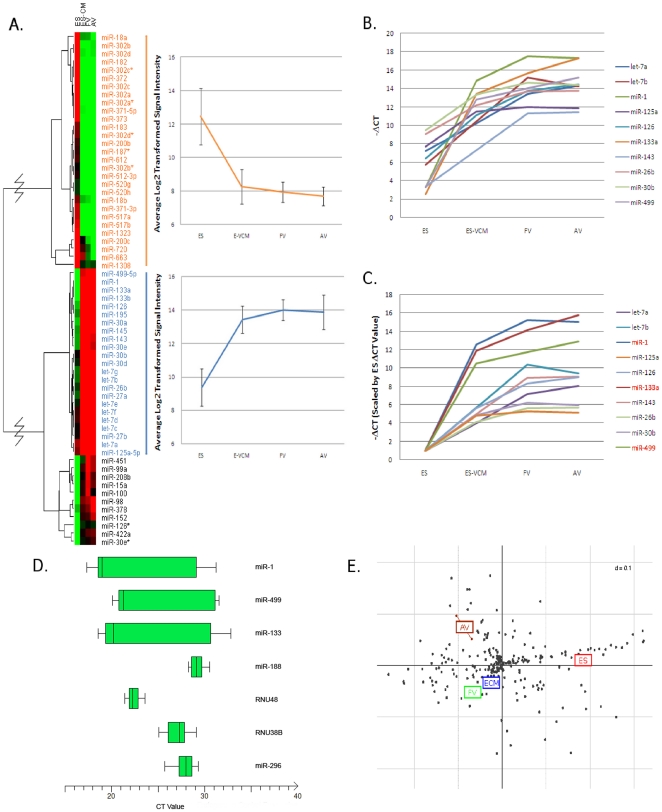
Characterization of miRNAs Present in hESC and Ventricular CMs.(A) A heatmap showing the results of ANOVA differential expression analysis; 63 miRs were differentially expressed between undifferentiated human ESC and hESC-derived VCMs (p<0.05). Red to green indicates high to low expression. Right panels: Average signal intensities of the 29 miRs differentially expressed in hESC (top), and the 23 miRs that displayed a “plateau” pattern across E-, F- and A-VCMs (bottom). (B) “Plateau” miRs validated with quantitative RT-PCR. (C) After normalized with the values of hESCs, miR-1, -133, and -499 displayed the highest differential expression between VCMs and hESCs. (D) MiR-188 and -296 were identified as stably expressed across developmental stages, at levels comparable to standard endogenous controls RNU38B and RNU48. Conversely, the expression of miR-1, -499, and -133 varies greatly across developmental stages. The box plot for each sample summarizes the median, first and third quartiles and range of raw CT values for each miRNA or endogenous control in all cell types assayed. (E) Between-group analysis (BGA) was carried out using principle component analysis (PCA) to provide a visual means to observe the variance of data in specified groups (G) along G-1 number of axes. Data points corresponding to individual miRs are distributed along the axes according to discriminating eigenvectors. Data points and groups that are strongly associated will be clustered within the graph due to their similar projection (both direction and distance) from the origin. Details on the calculations used in BGA can be found in Culhane et al. (2002) [38].